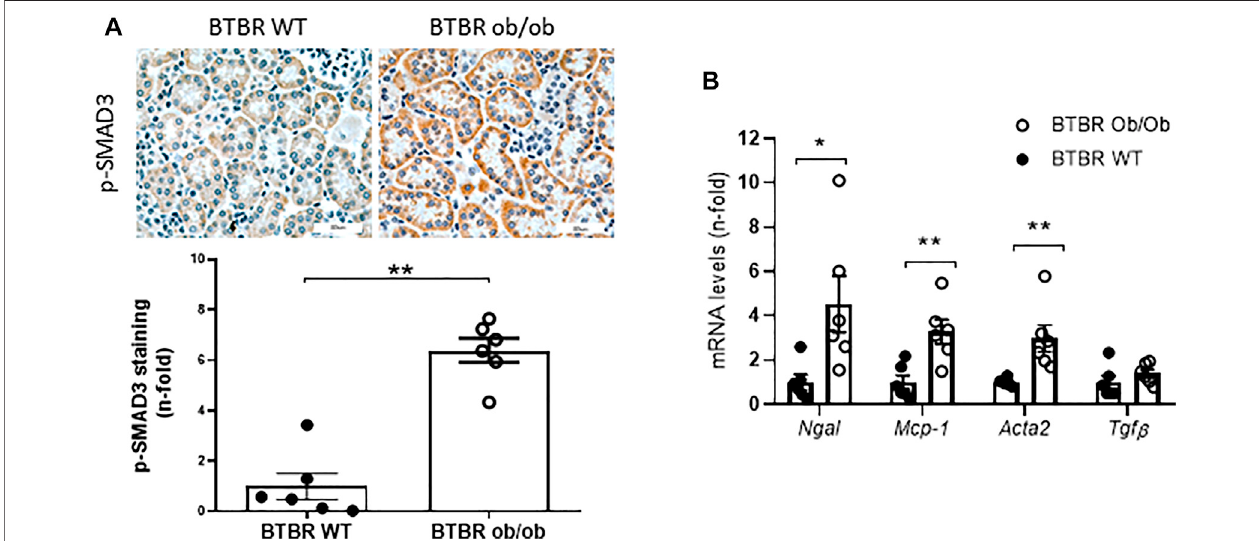
FIGURE 2 | Evaluation of the SMAD pathway activation and in fl ammatory and fi brotic markers. (A) Increased kidney levels of phosphorylated SMAD3 ( p -SMAD3) were observed in BTBR ob/ob of 22 weeks old compared to BTBR WT. (B) Increased levels of Ngal , Mcp-1 , and Acta2 were observed in the BTBR ob/ob group comparedtoBTBRWTmice,whereas nodifferencesweredetectedin Tgf- β expression levels. Dataareshown asmean ±SEMandgraphsbar withscatter dotplotsof each group ( n = 6 mice/group). *** p < 0.001 vs . BTBR WT; ** p < 0.005 vs. BTBR WT; * p < 0.05 vs. BTBR WT.